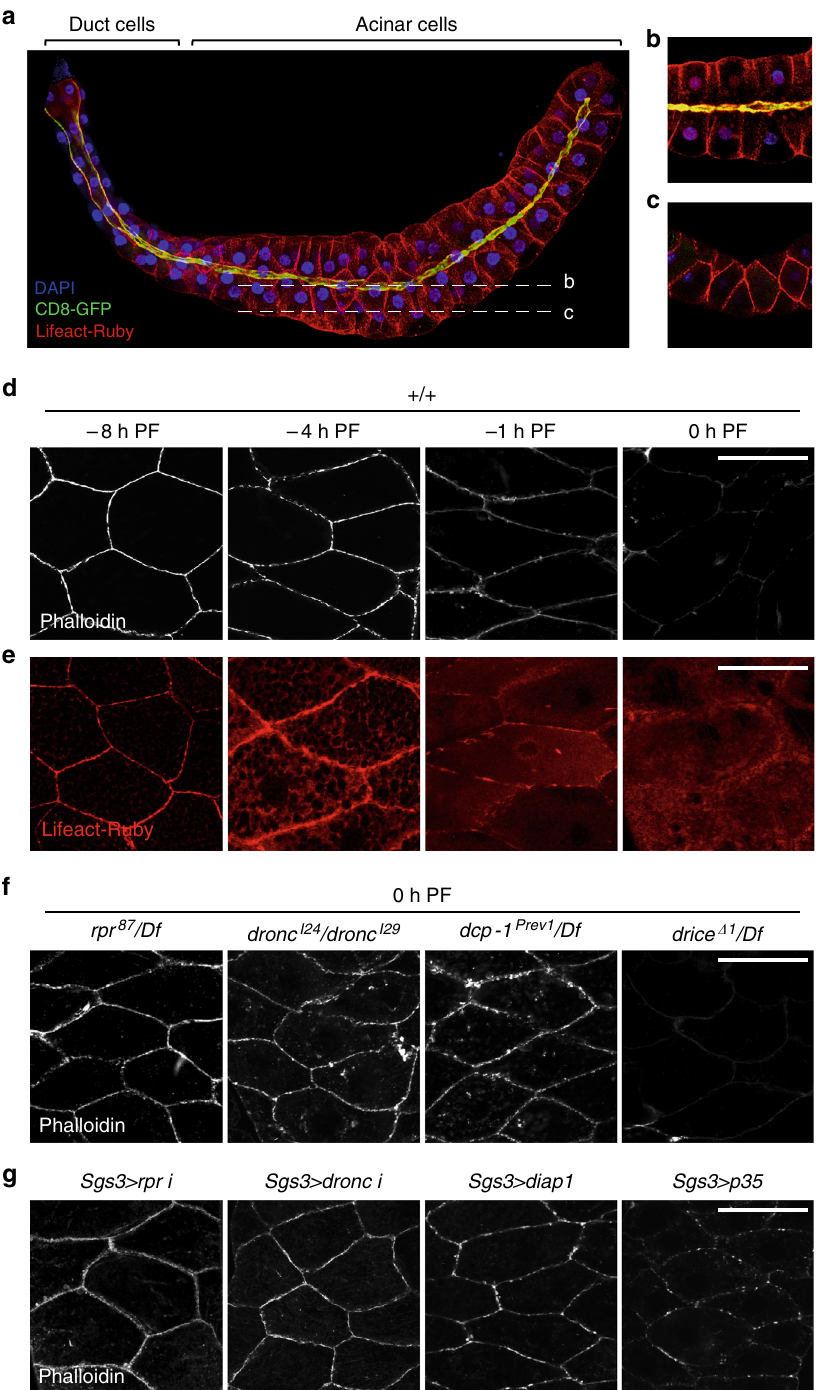
Fig. 2 A rpr -triggered caspase cascade dismantles the cortical F-actin cytoskeleton in living salivary glands. a Maximal intensity projection of a whole salivary gland at − 8 h PF expressing the actin-binding peptide Lifeact-Ruby in red and the membrane marker CD8-GFP in green , both under control of the salivary gland driver fkh-GAL4 . CD8-GFP is enriched at the apical membrane (proximity of Lifeact-Ruby and CD8-GFP at the apical membrane appears yellow ); nuclei stained by DAPI in blue . b , c Confocal slices through the salivary glands. b A medial slice shows an apical – basal view of acinar cells, with the lumen in the middle. c A lateral slice shows a “ coronal ” view, highlighting the cortical F-actin cytoskeleton. d , e Cortical F-actin breaks down at the end of larval development. d Phalloidin staining ( white ) in salivary glands at − 8 h PF reveals tight cortical bundles of F-actin; this structure begins to disintegrate at − 4 h PF and − 1 h PF, with no phalloidin staining visible by 0 h PF. e Lifeact-Ruby in salivary glands con fi rms cortical F-actin breakdown. Lifeact-Ruby reveals that most of the actin in the cell is present at the cortex at − 8 h PF. Breakdown of F-actin is re fl ected by a gradual redistribution of Lifeact-Ruby signal from the cortex to the cytoplasm at − 4 h PF and − 1 h PF, with only cytoplasmic signal visible at 0 h PF. f F-actin dismantling requires caspase activity. F-actin breakdown is blocked in rpr , dronc , and dcp-1 mutant salivary glands, but not in drice mutant salivary glands. g Caspases regulate F-actin breakdown cell- autonomously. Salivary gland-speci fi c (using Sgs3-GAL4 ) overexpression of rpr-RNAi , dronc-RNAi , or of the caspase inhibitors diap1 or p35 inhibits F-actin breakdown. Scale bars represent 100 µ m. Df, de fi ciency, PF, puparium